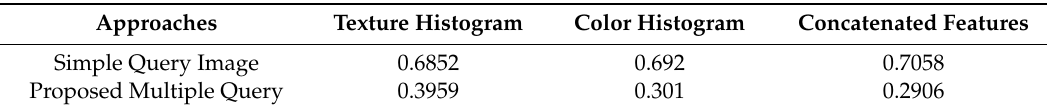
Table 3. Comparison of the performance of the proposed multiple query approach vs. the performance of a simple query image using a texture histogram, color histogram, and concatenated features based on average normalized modified rank retrieval (ANMRR).